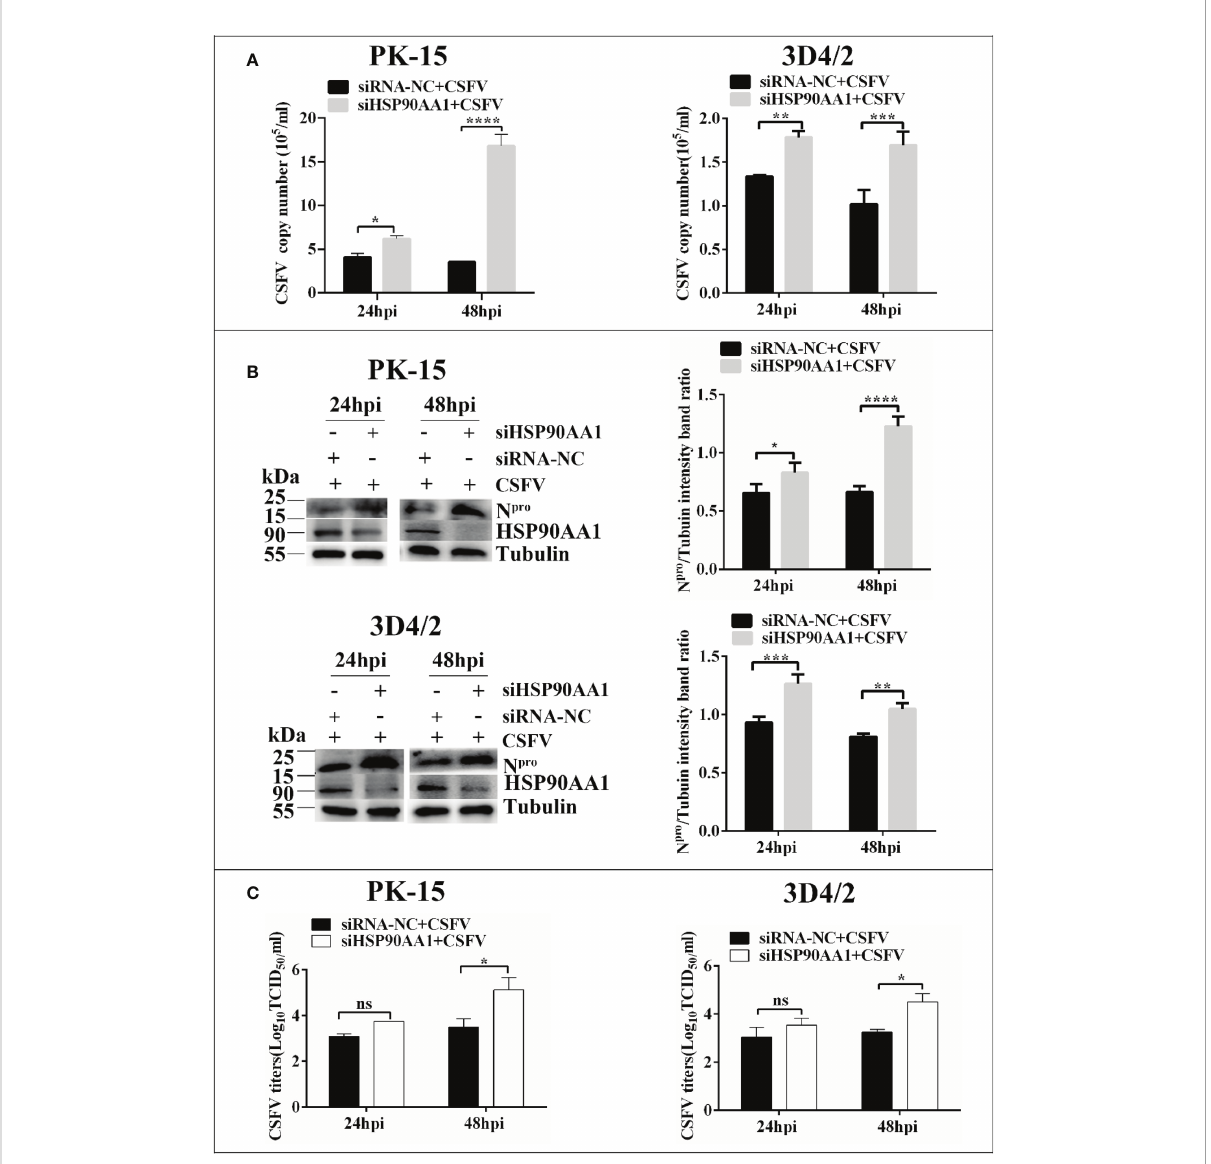
FIGURE 3 Knockdown of HSP90AA1 promoted CSFV replication. (A) RT-PCR determined CSFV NS5B copy numbers at 24 and 48 hpi in HSP90AA1 knockdown PK-15 and 3D4/2 cells. (B) Western blot for HSP90AA1 and CSFV N pro expression in HSP90AA1 knock-downed PK-15 and 3D4/2 cells, and the relative levels of N pro in HSP90AA1 knock-downed PK-15 and 3D4/2 cells were estimated by histograms representing density readings of the gel bands with Image J, and the ratios were calculated relative to tubulin control. (C) Infectious progeny viral titers in supernatants from HSP90AA1-knockdown PK-15 and 3D4/2 cells. Viral titers from the supernatant collected at 24 and 48 hpi were determined and expressed as TCID 50 /ml. (*p < 0.05, **p < 0.01, ***p < 0.001 and ****p < 0.0001 calculated using two-way ANOVA, ns, not signi fi